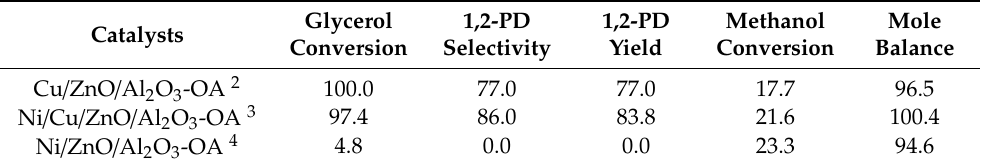
Table 5. Promoting e ff ect of Ni on Cu / ZnO / Al 2 O 3 -OA activity for glycerol hydrogenolysis and methanol steam reforming 1